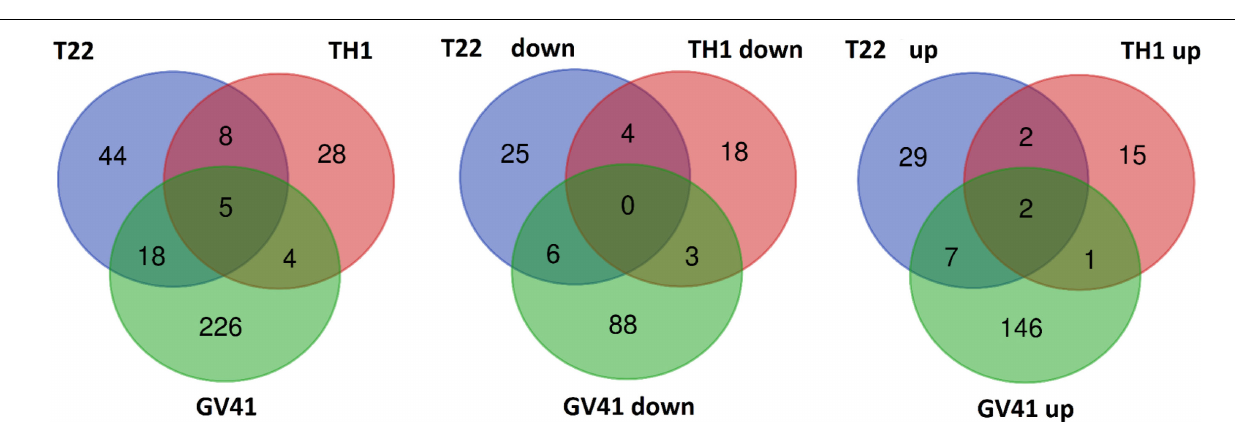
FIGURE 2 | Venn diagram showing differentially represented proteins present in strawberry fruits produced by plants subjected to the treatment with Trichoderma strains (T22, TH1, and GV41), as compared to control. Diagrams refer to all differentially represented proteins (left) , those down-represented (middle) and over-represented (right) ,